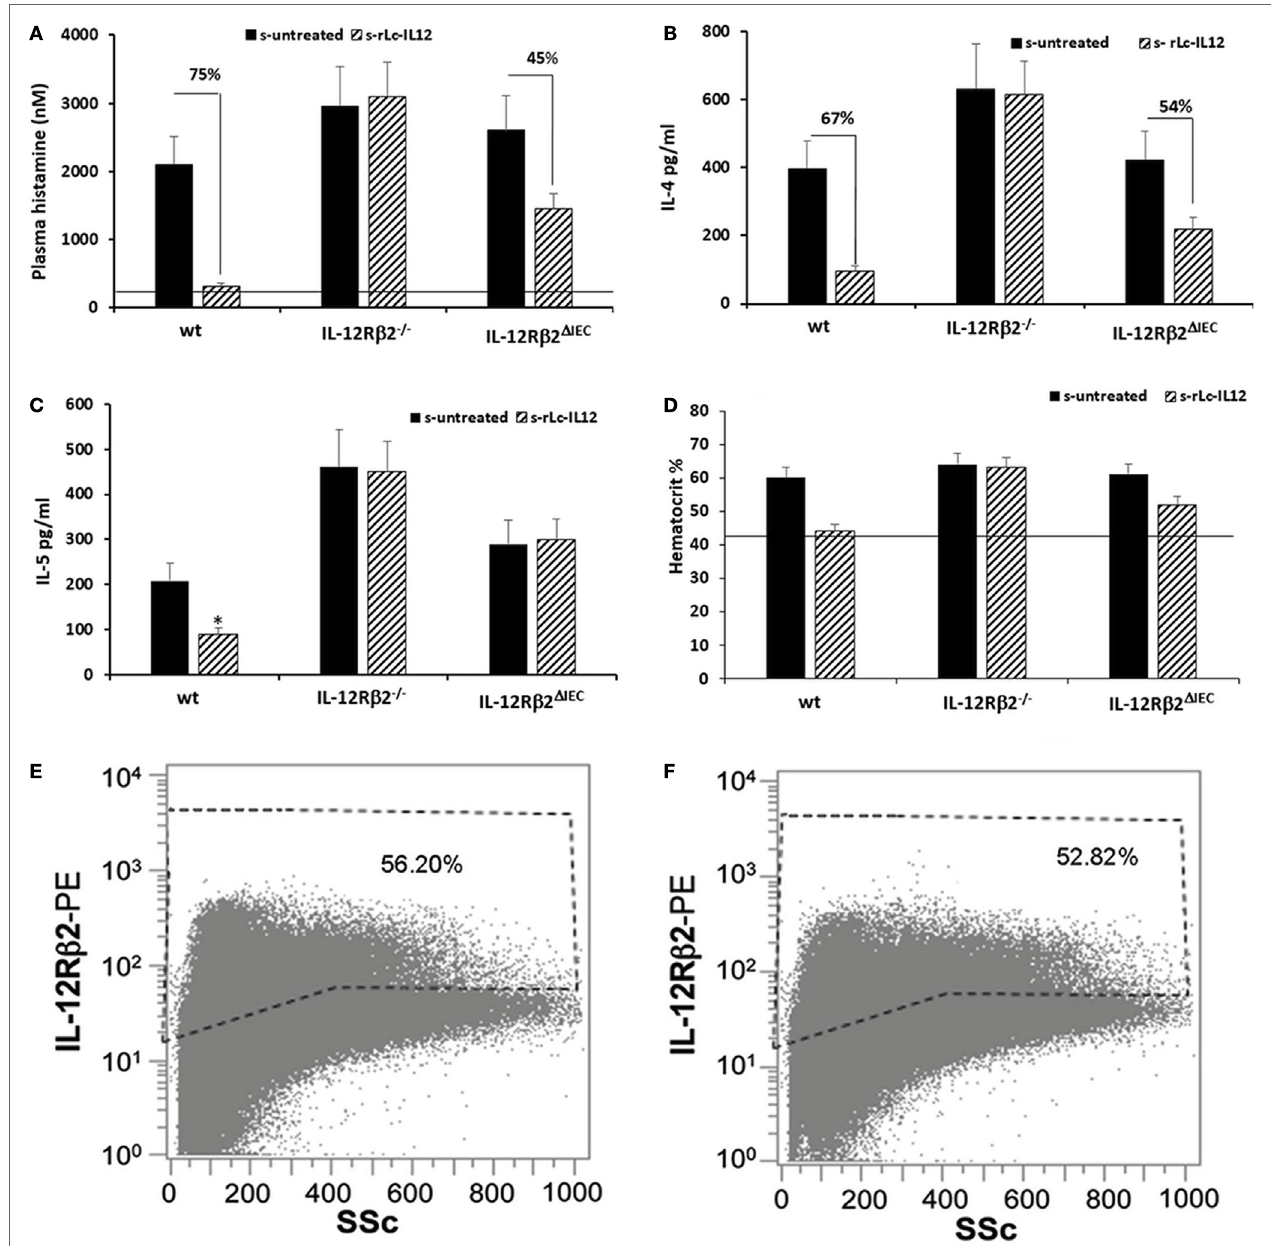
FigUre 6 | Efficacy of rLc-IL12 on additional parameters of food allergy in sensitized wild-type (wt) and chimeric mice . Oral administration of IL-12 reduced levels of plasma histamine by 75% in sensitized wt mice compared to IL-12 untreated syngeneic mice (a) . By contrast, no effects were seen in chimeric IL-12R β 2 − / − mice; instead the IL-12 mediated reduction of plasma histamine in chimeric IL-12R β 2 ∆ IEC totaled only to 45%. Also, levels of IL-4 produced by splenocytes following in vitro recall allergen challenge showed a similar pattern (B) . Production of IL-4 in wt mice treated with rLc-IL12 dropped 67% compared to sensitized untreated mice; the same treatment was not effective in chimeric IL-12R β 2 − / − mice and only partially effective in IL-12R β 2 ∆ IEC mice (54%). By contrast, levels of IL-5 following in vitro recall allergen challenge were reduced by rLc-IL12 only in wt but not in either chimeric mouse variants (c) . Hematocrit was evaluated as a measure of vascular leakage (D) . Administration of rLc-IL12 restored near physiological levels of hematocrit in wt mice; no effects were seen in chimeric IL-12R β 2 − / − mice and only partial restoration of the hematocrit was seen in chimeric IL-12R β 2 ∆ IEC . Finally, representative histograms showed that levels of IL-12R β 2 on intestinal epithelial cells (IECs) did not vary between sensitized (F) and naïve mice (e) . Statistical analysis (8–10 mice group) was carried out by (ANOVA) Wilcoxon rank test. * p <